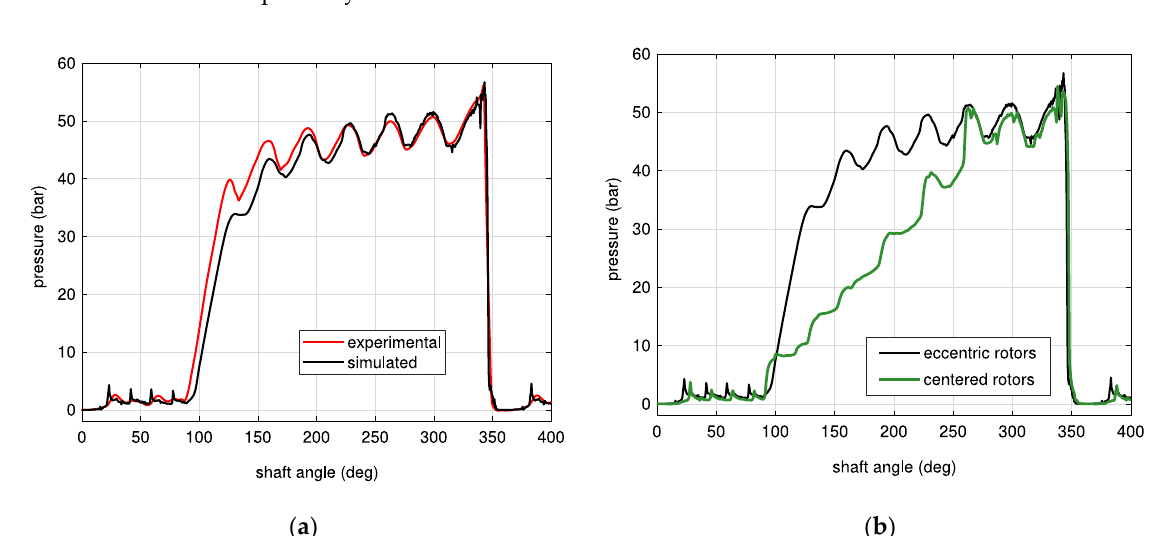
Figure 13. Chamber pressure at 1000 rpm with plates B: ( a ) comparison experimental-simulated data; ( b ) influence of the geometry of the position of the gears’ axes (simulated).